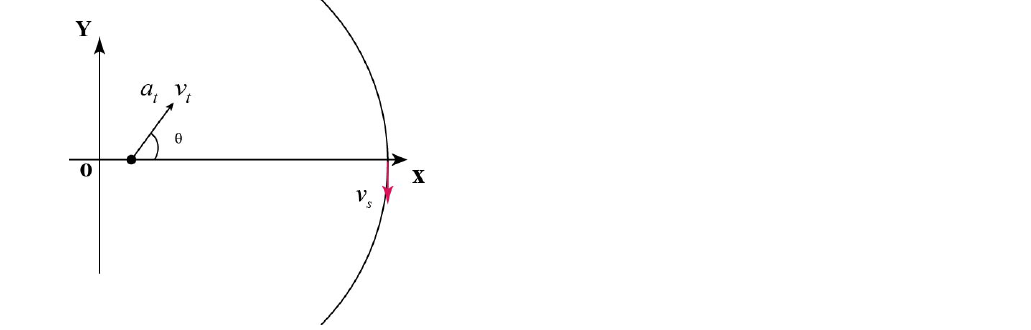
Figure 13. Top view of target and radar relative motion at time t = 0 (constant acceleration target). The target motion functions are given as